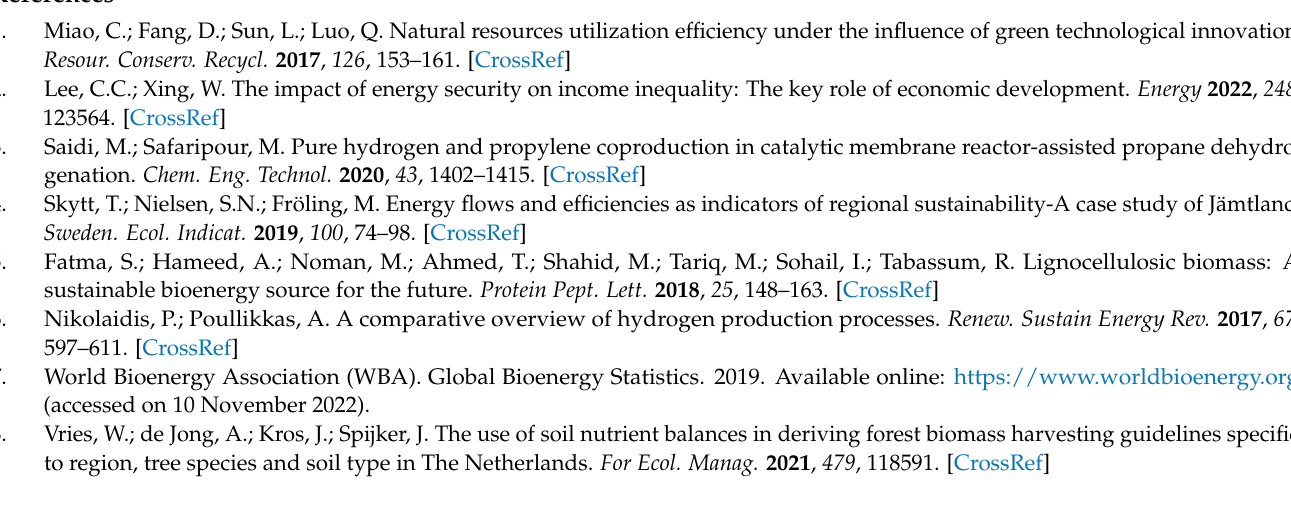
ple; Table S2: GC–MS analysis of the methanol sample; Table S3: GC–MS analysis of benzene/ethanol sample; Table S4: GC–MS analysis of the ethanol/methanol sample; Table S5: Py/GC–MS analysis of S. holocarpa